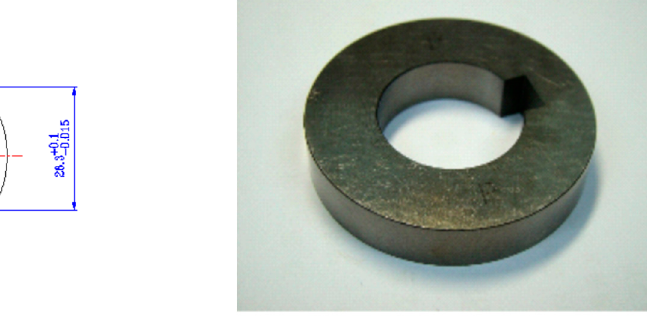
Figure 15. Shape and dimensions of rolling contact specimen.